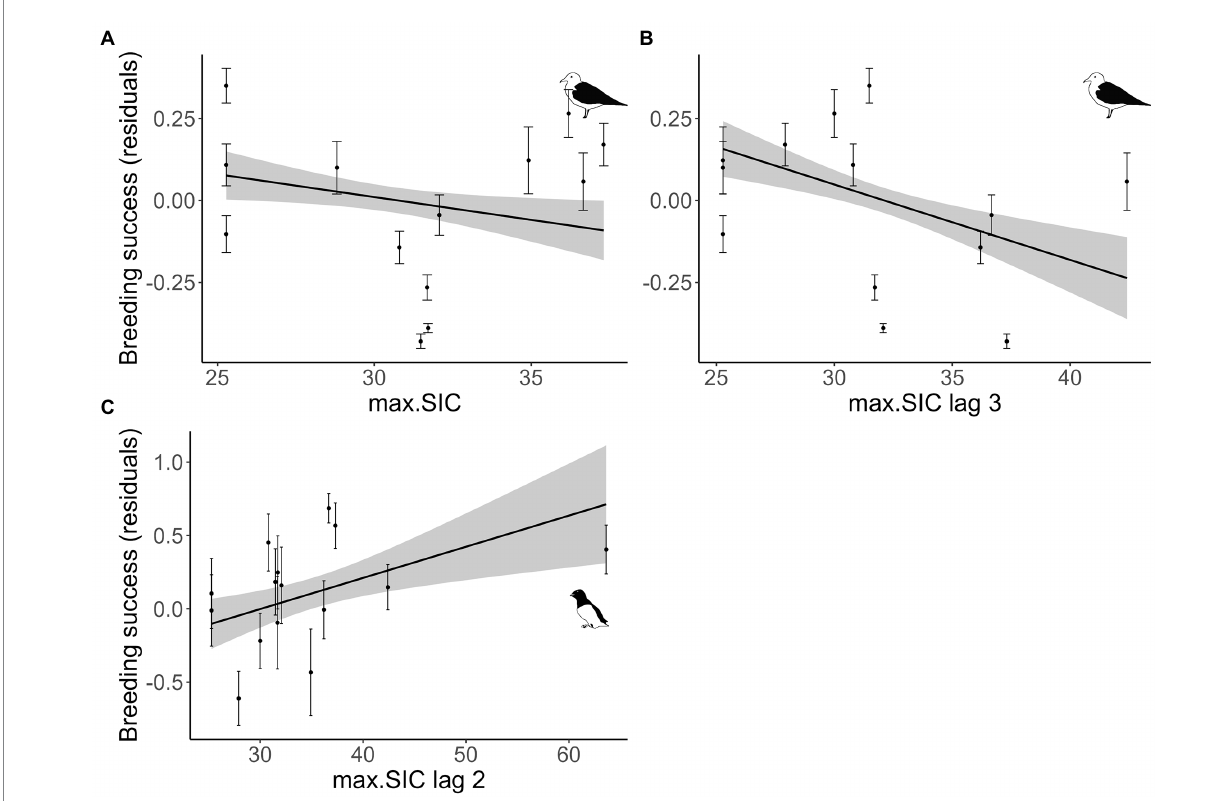
FIGURE 4 Relationship between maximum sea-ice concentration (max. SIC ) with or without a lag (lag 2 = 2 years, lag 3 = 3 years) and breeding success probability of kittiwakes (A,B) and little auk (C) in Isfjorden (west Svalbard). Plain lines correspond to estimated relationships from a linear model considering the detrended time-series with associated 95% confidence intervals. Dots correspond to residuals from the time-series adjusted for their trends with standard